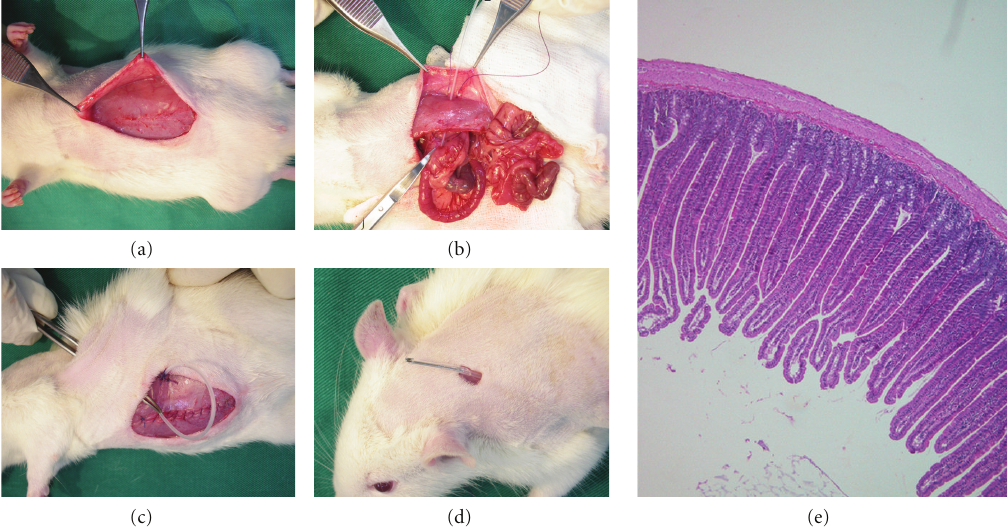
Figure 1: Percutaneous gastroduodenojejunostomy to deliver FDS or vehicle directly to the jejunal mucosa of Lewis rats. (a) Midline laparotomy. (b) Silicone tubing was delivered through the anterior abdominal musculature into the stomach and passed distal to the Treitz ligament. (c) The abdomen was closed and the tubing secured to abdominal wall musculature and tunneled to the posterior neck. (d) The tube was additionally secured at the posterior neck and sealed with a stopper that could be removed and replaced for intrajejunal administrations. (e) Characteristic jejunal histological appearance of intestinal tissue 5mm distal to the tube end at time of sacrifice confirmed correct intrajejunal placement in all